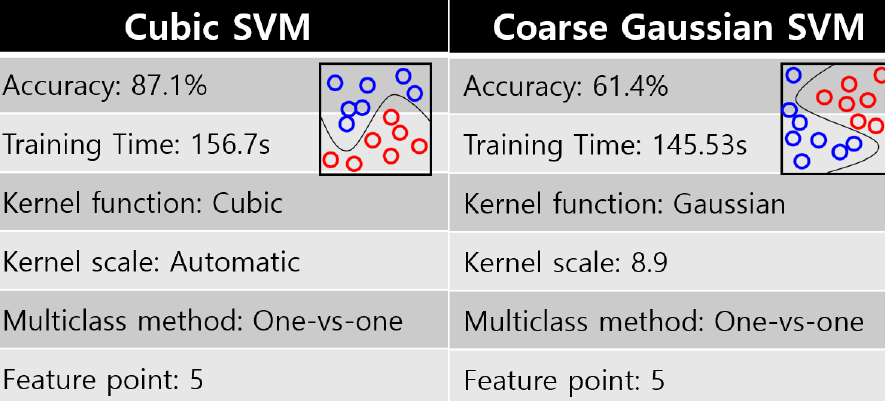
Figure 6. Classification results using Cubic SVM and Coarse Gaussian SVM, Cubic SVM represents the best case, and Coarse Gaussian SVM represents the worst case.